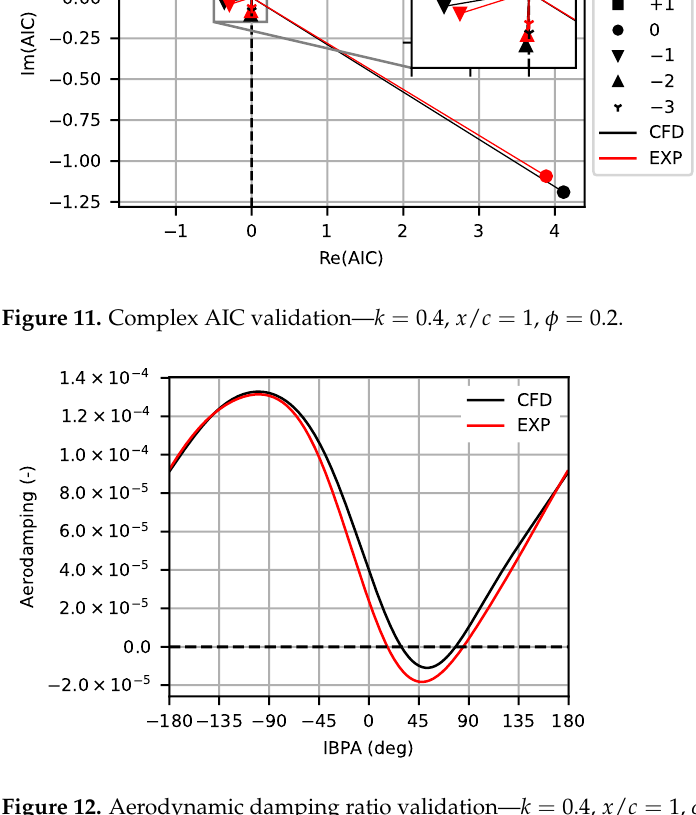
Figure 12. Aerodynamic damping ratio validation— k = 0.4, x / c = 1, φ =